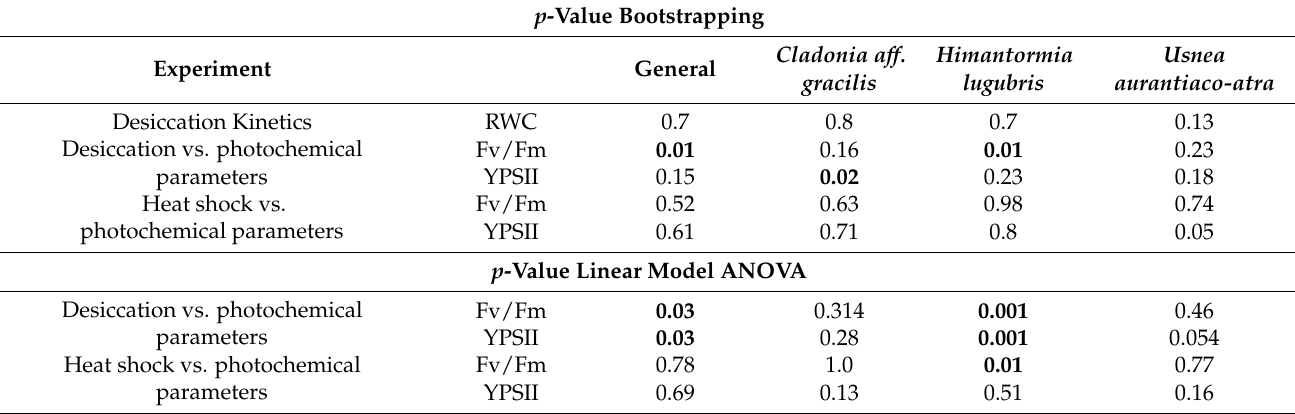
Table 1. Results ( p -value) of statistical analyses performed to compare chlorophyll fluorescence values (Fv/Fm and YPSII) obtained from three Antarctic lichen species subjected to long-term passive warming treatments through desiccation kinetics experiments and thermal shock treatments; p - values are shown for the pool of all species (general) and for individual species for bootstrapping permutations and ANOVA; in the case of one-way ANOVA p -values correspond to the section of the curve that fits to a linear theorical model according to Figures 4 and 6. p -Value